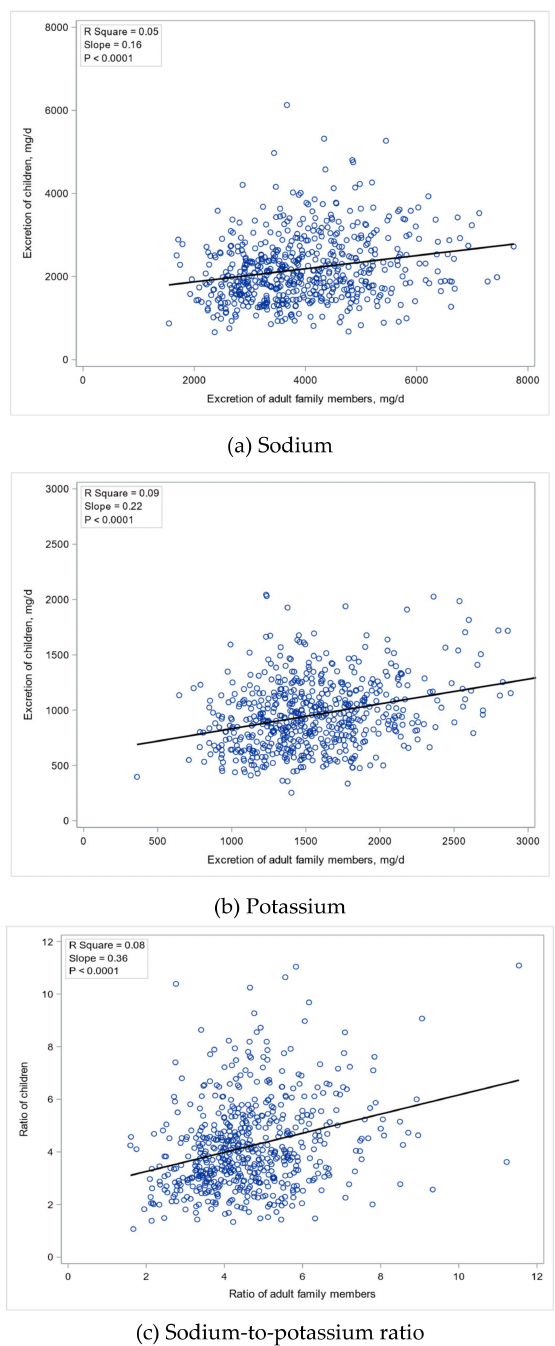
Figure 2. Distribution of sodium, potassium excretion and sodium-to-potassium molar ratio of the children and their adult family members. ( a ) Sodium, ( b ) Potassium, ( c ) Sodium-to-potassium ratio. The black line represents the regression